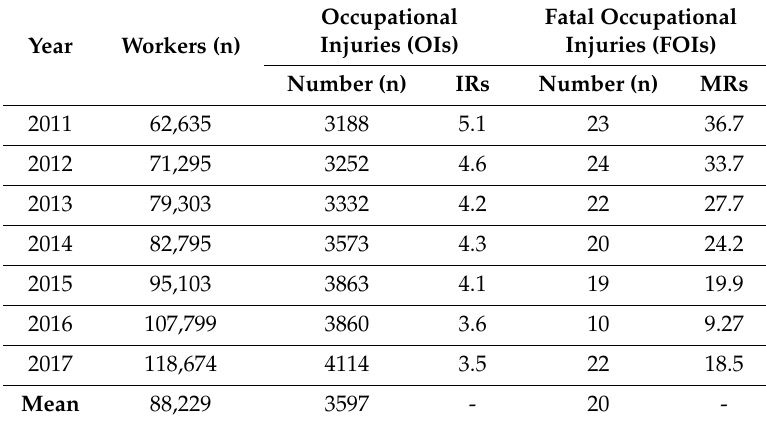
Table 1. The details of construction workers and occupational injuries among Hong Kong construction workers from 2011 to 2017.